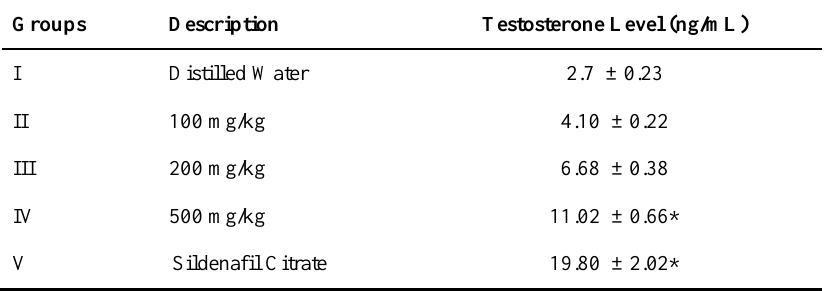
Table 1.5: Effect of MPAE on Testosterone level of the male